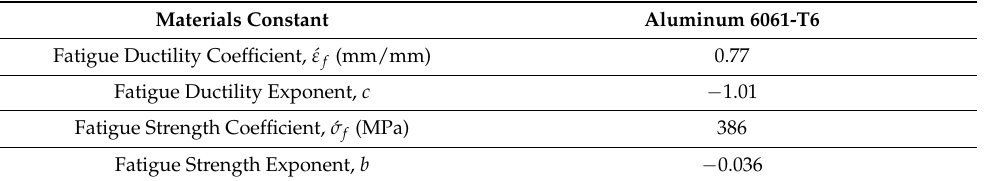
Table 5. Materials parameters for aluminum 6061-T6 [32].